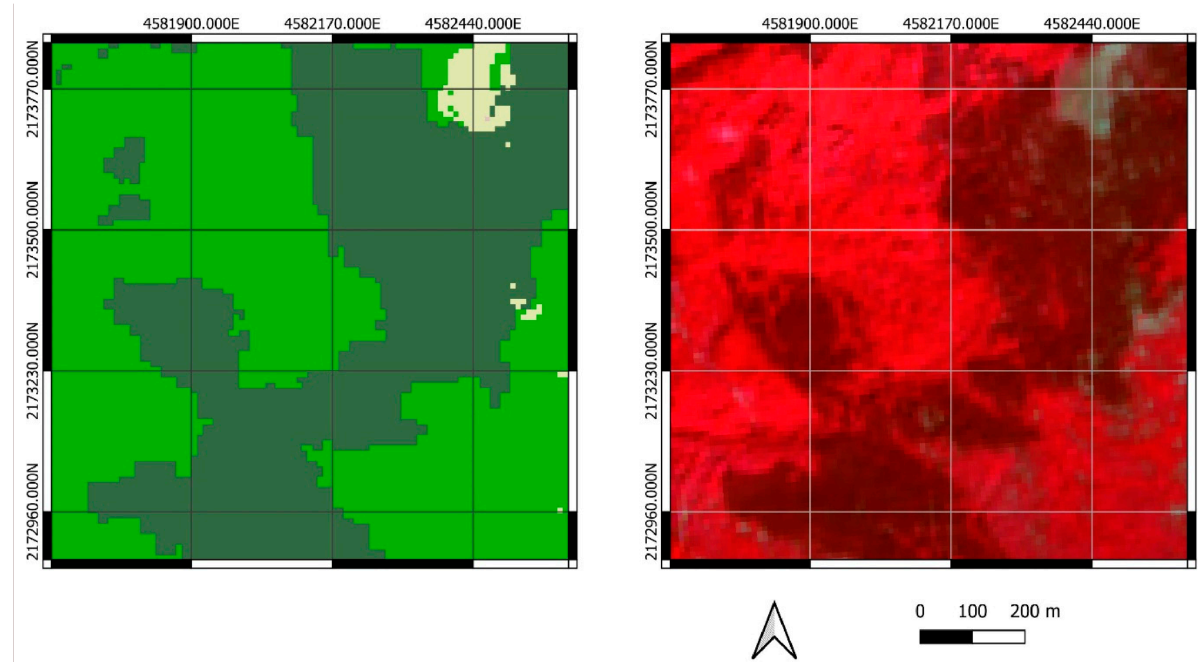
Figure 9. Woody vegetation, the distinction between broad-leaved ( brighter ) and needle-leaved ( darker ). The results obtained for the herbaceous cover are related with the definition of the classes of periodic (Figure 10) and permanent (Figure 11) herbaceous, which consider the persistence of the herbaceous cover in the pixel throughout the year. In detail, pixels showing herbaceous cover in at least 95% of valid observations were classified as per- manent herbaceous. This threshold is conservative and aligned with the definitions of CLC+ products [61], but it could be adapted to different temporal definitions.